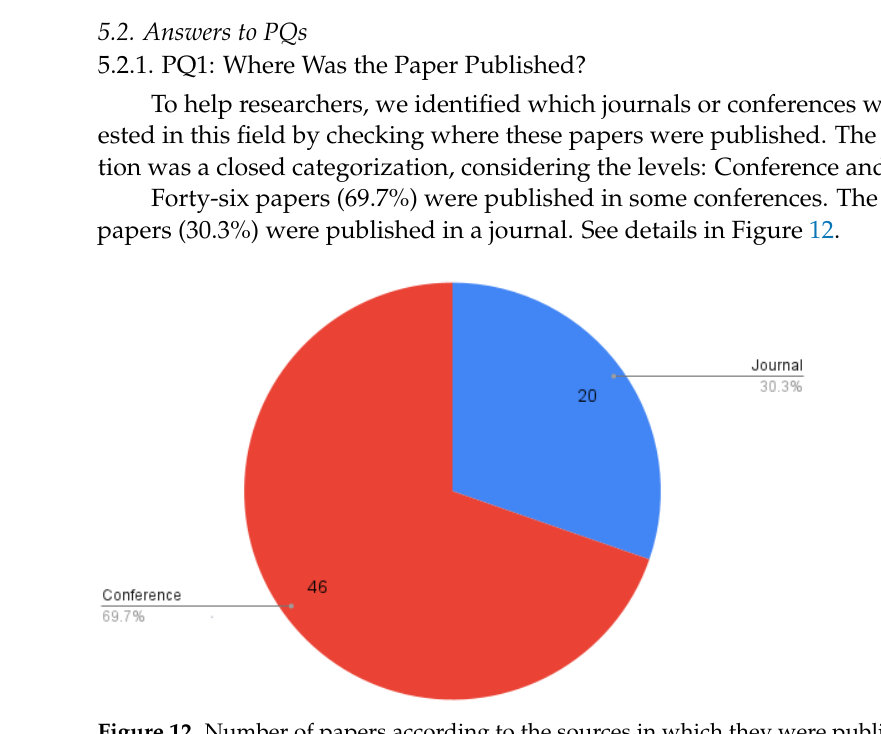
Figure 12. Number of papers according to the sources in which they were published.